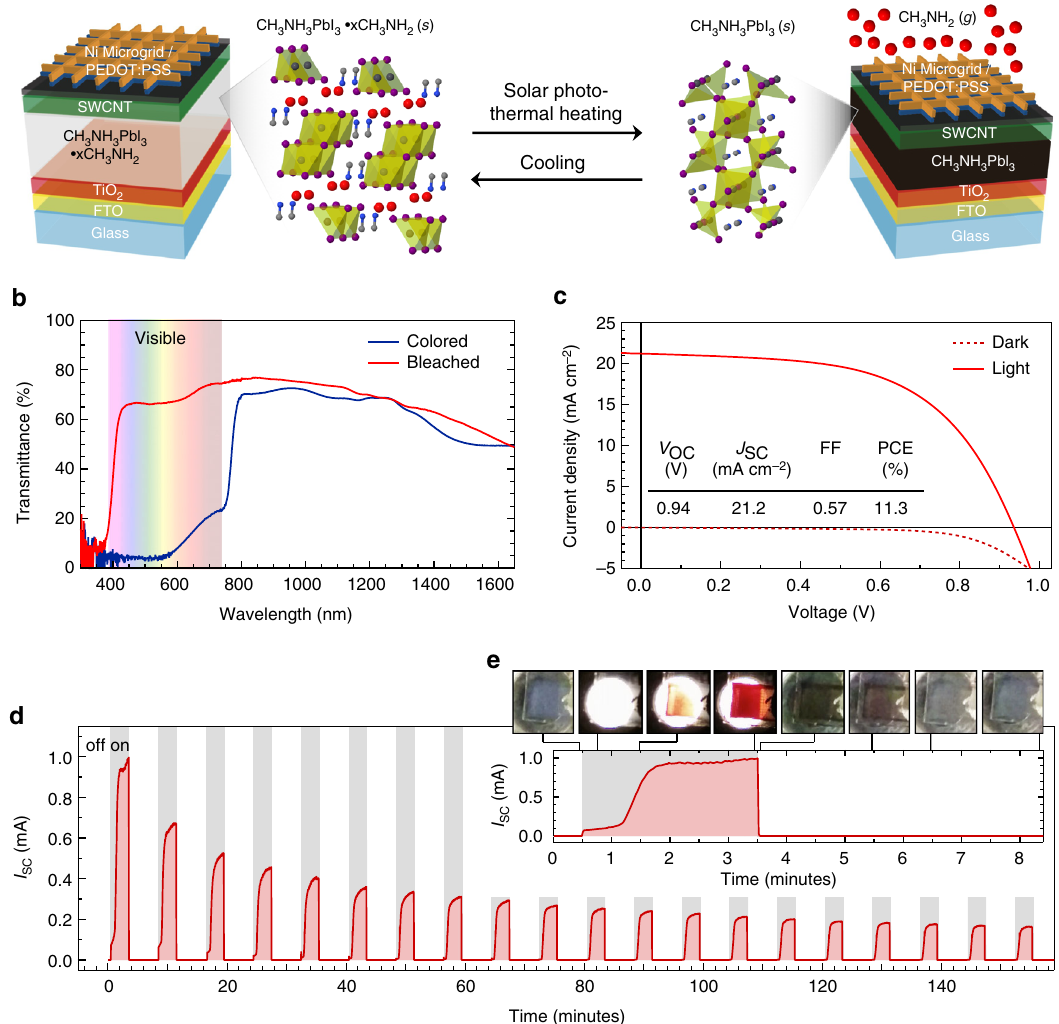
Fig. 1 Composition and performance of switchable photovoltaic window devices. a Schematic of PV window device architecture and switching process. b Transmittance of PV devices in the bleached (red) and colored (blue) states as a function of wavelength. c Current density as a function of voltage of the champion switchable PV device in the dark (dashed) and under illumination (solid). The inset table shows PV performance metrics of the device before being bleached. d Short-circuit current as a function of time for 20 cycles of 3 min of illumination followed by 5 min of cooling in the dark. e Short-circuit current as a function of time for the fi rst illumination cycle. The optical images were extracted from Supplementary Movie 1 to show the transition from bleached to colored and back to bleached at the indicated times during the cycling